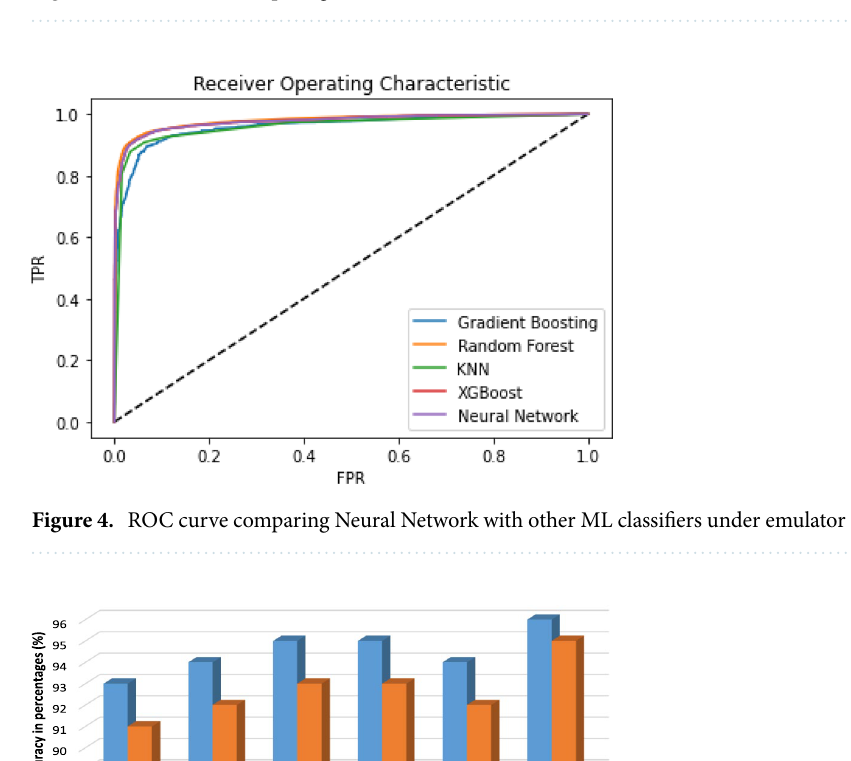
Figure 3. ROC curve comparing Neural Network with other ML classifiers under real device dataset.